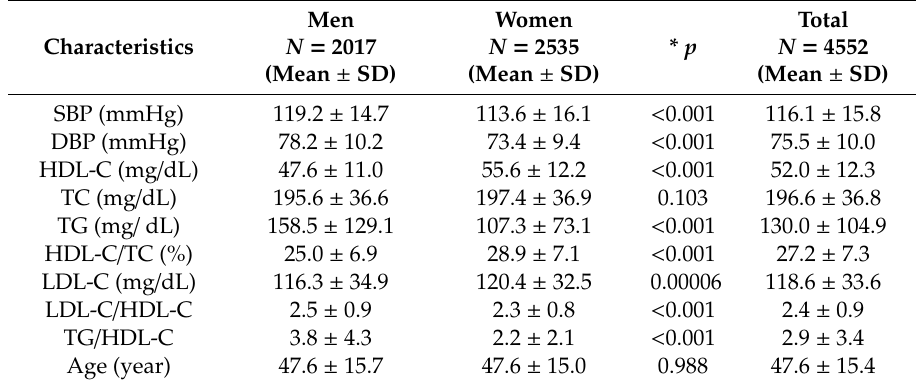
Table 1. General characteristics of total population in this study from Korean national health and nutrition examination survey